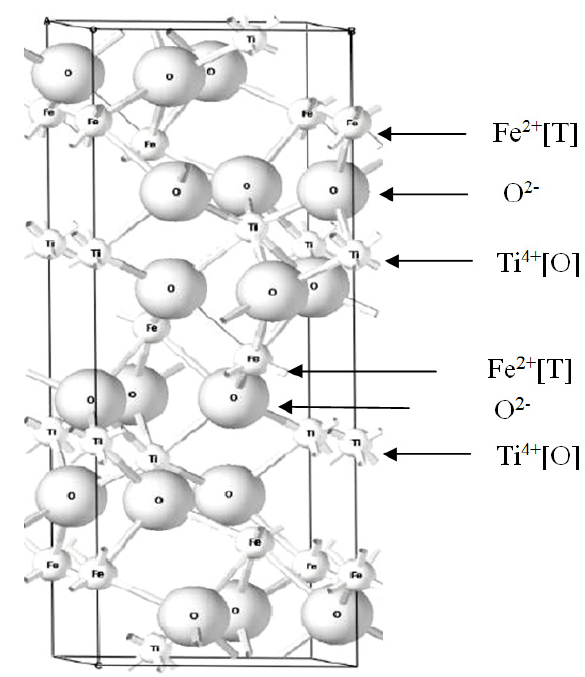
Figure 2: Ilmenite crystalline structure [O]: Octahedral site, [T]: Tetrahedral site.